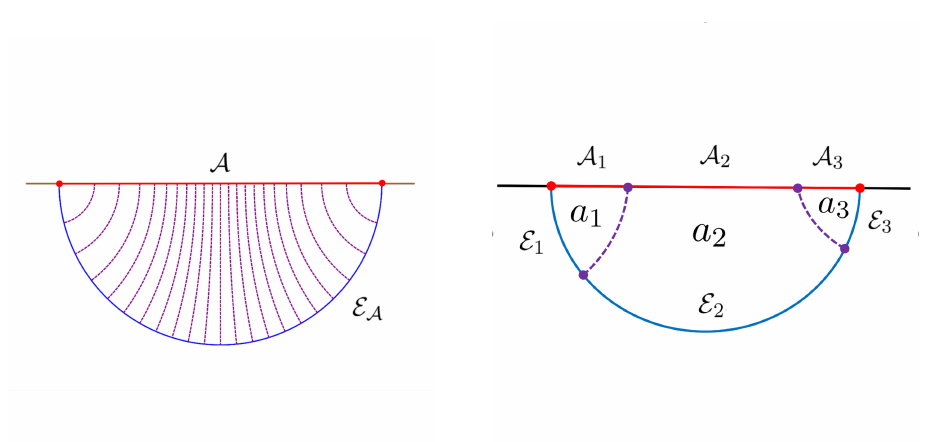
Figure 4: The above two figures show a time slice of the entanglement wedge. The purple dashed lines are the γ curves, which are static geodesics normal to E P the right figure, the decomposition of A induces a decomposition of the homology surface Σ and the RT surface E A A